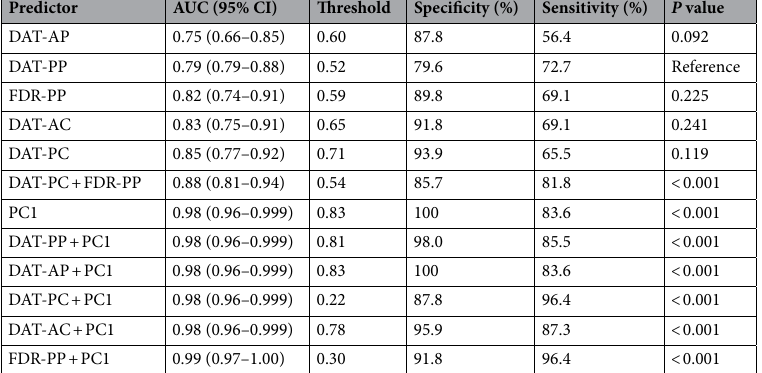
Table 3. ROC curve analyses for the diagnosis of DLB. Results correspond to ROC curve analyses for the diagnosis of DLB. P values are the results of analyses based on DeLong’s method comparing each model’s accuracy with that of the model using DAT-PP as a predictor. AUC area under the curve, DAT dopamine transporter, DAT-AC DAT uptake in the anterior caudate, DAT-AP DAT uptake in the anterior putamen, DAT-PC DAT uptake in the posterior caudate, DAT-PP DAT uptake in the posterior putamen, DLB dementia with Lewy bodies, FDG 18 F-fluorodeoxyglucose uptake, FDR-PP FDG to DAT ratio in the posterior putamen, PC1 the first principal component of FDG subject residual profile, ROC receiver operating